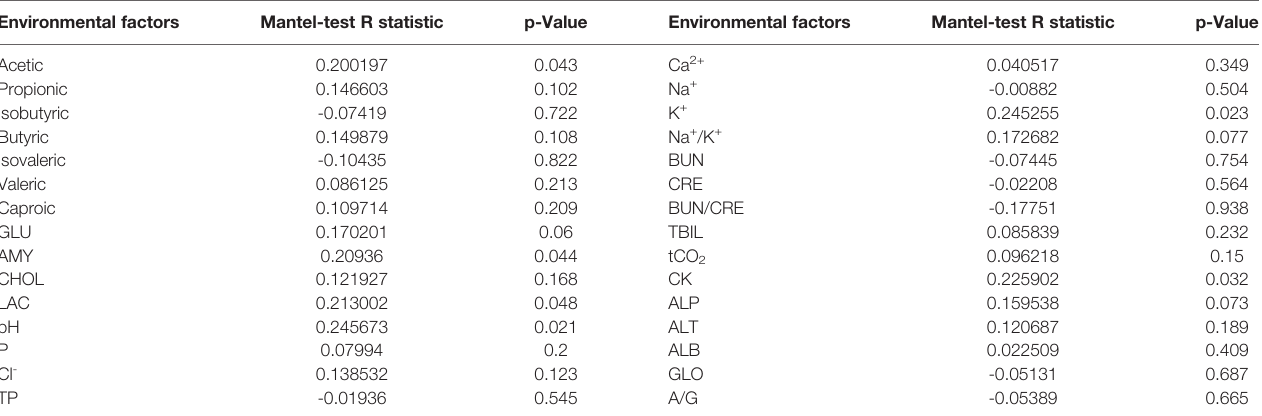
TABLE 1 | Correlation analysis of microorganisms and metabolites Mantel-test.